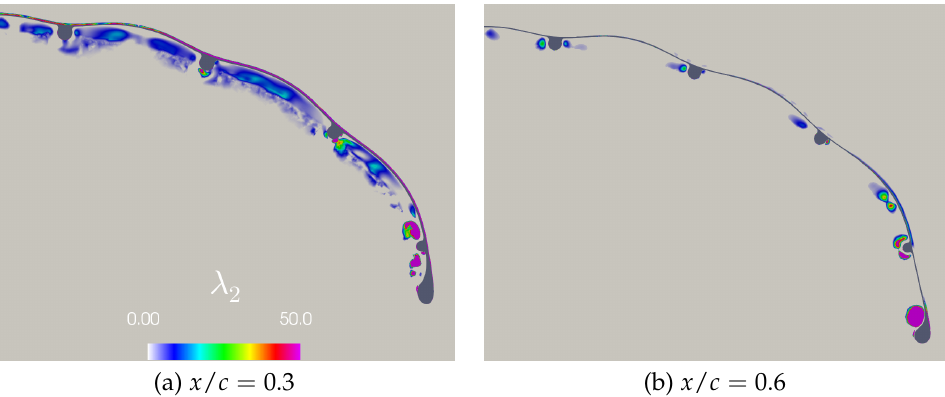
Figure 10. λ 2 -criterion for Re = 3 × 10 6 and α = 12 ◦ in slices perpendicular to the incoming flow, taken from [23].